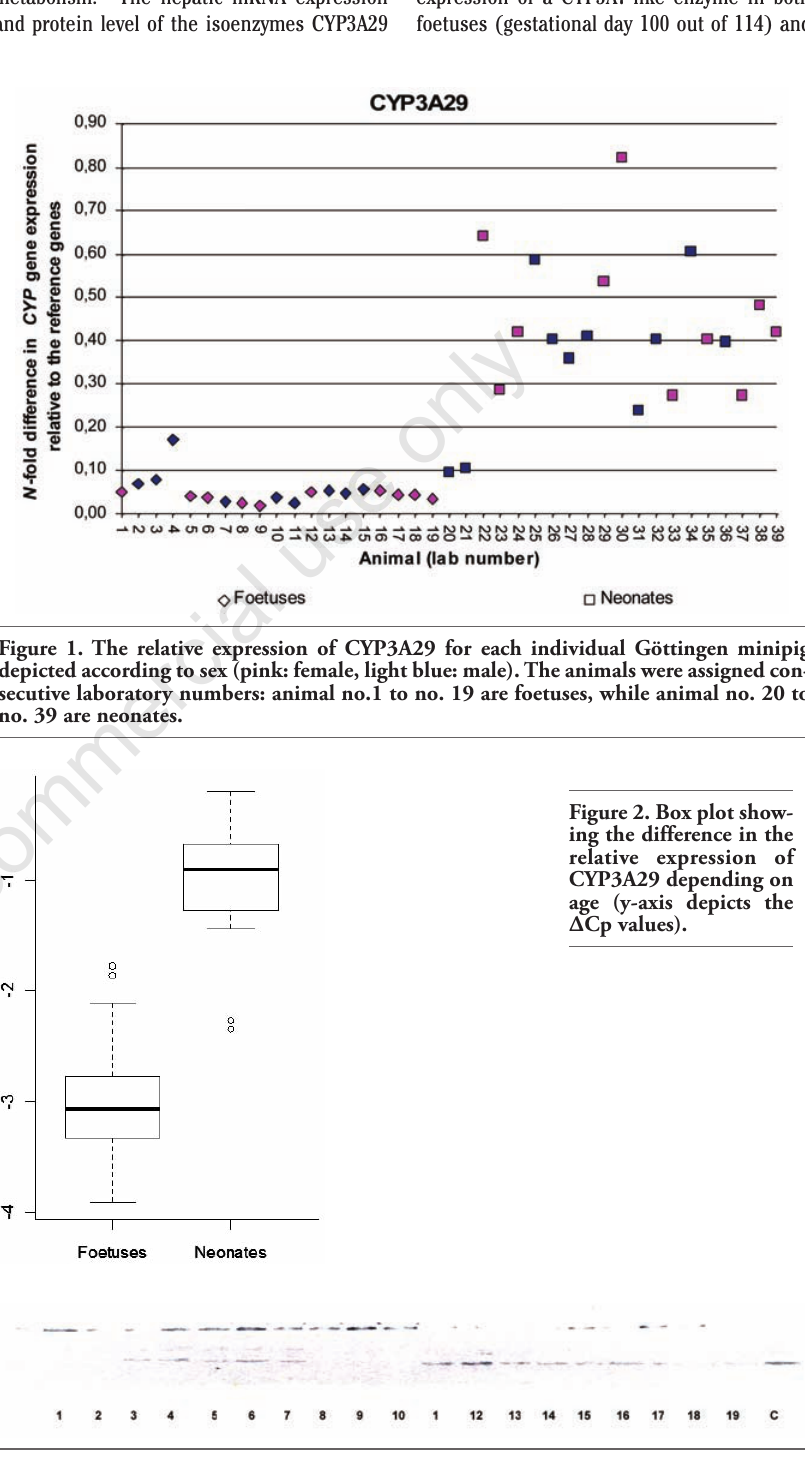
Figure 3. Western blot for 10 foetuses, lane 1-10, and 9 neonates, lane 11-19, female Göttingen minipigs. Upper lane incubated with anti-human CYP3A7, lower incubated with anti-human